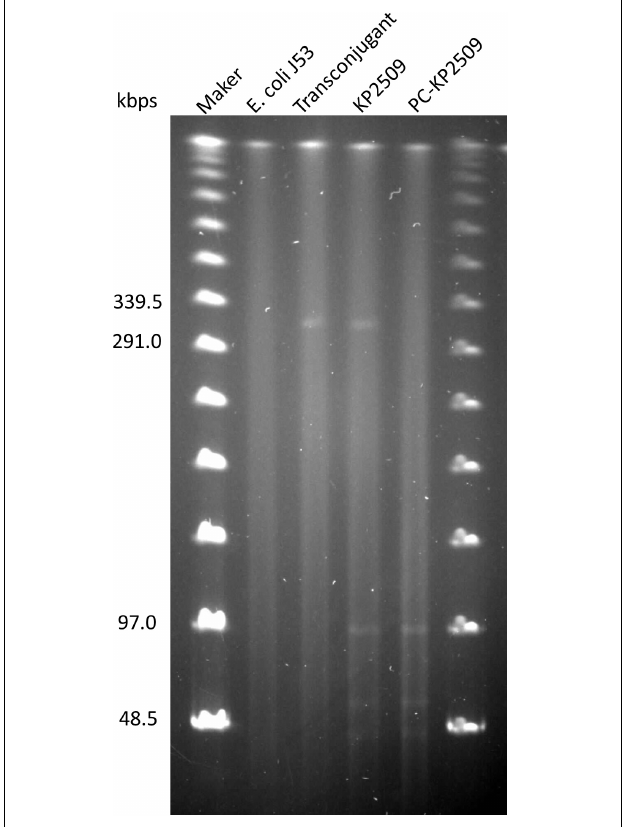
FIGURE 2 | Genomes of E. coli J53 (lane 2), transconjugant (lane 3), KP2509 (lane 4) and PC-KP2509 (lane 5) were treated with S1-nuclease, and the resulting products were subsequently analyzed by PFGE. The profile showed an approximately 300 kbps plasmid in the transconjugant, that is consistent with the mcr-1 -harboring plasmid from KP2509. Only four plasmids of KP2509 were detected in the gel, because the small size (10,060 bp) of the undetectable plasmid, pKP2509-5, was below the lower limit of